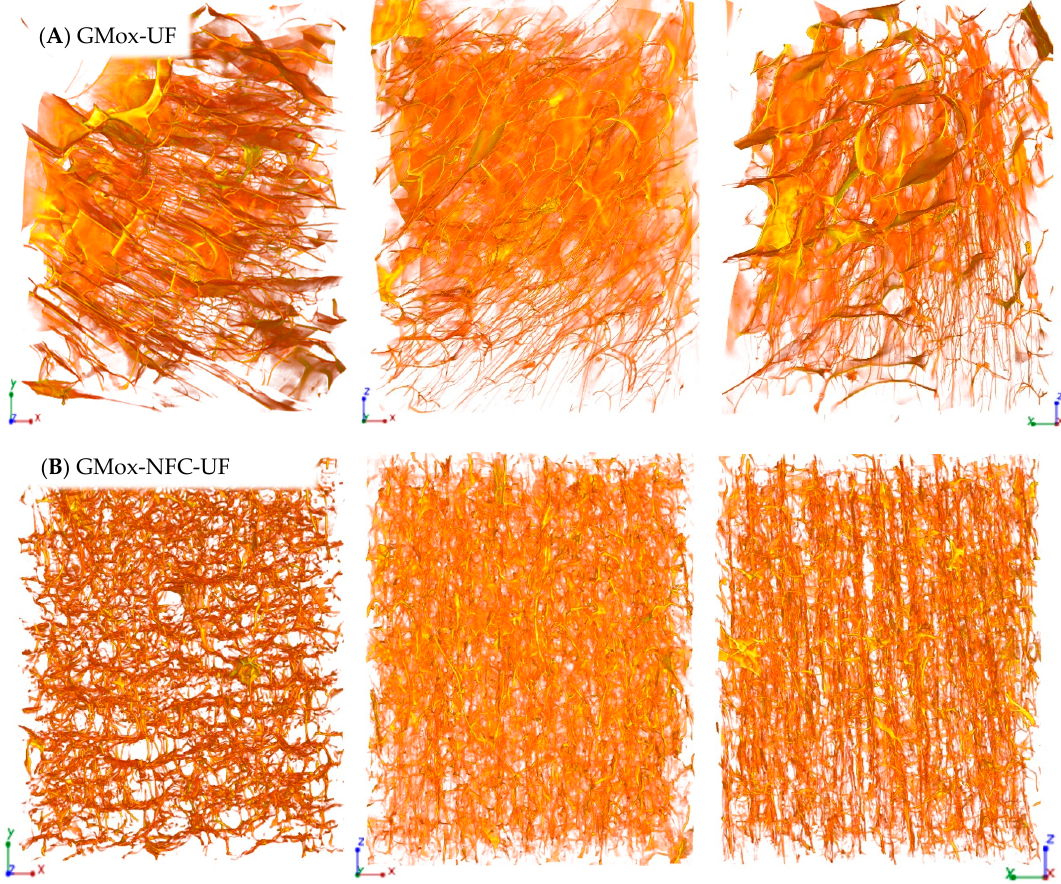
Figure 3. Three-dimensional reconstructed images from synchrotron phase contrast microtomography of ( A ) oxidized GM (GMox) aerogel and ( B ) aerogel reinforced with 25% NFC (GMox-NFC), prepared by unidirectional freezing (UF) using liquid nitrogen. The size is 495.33 × 495.33 × 660.33 μ m 3 in XYZ-axis.